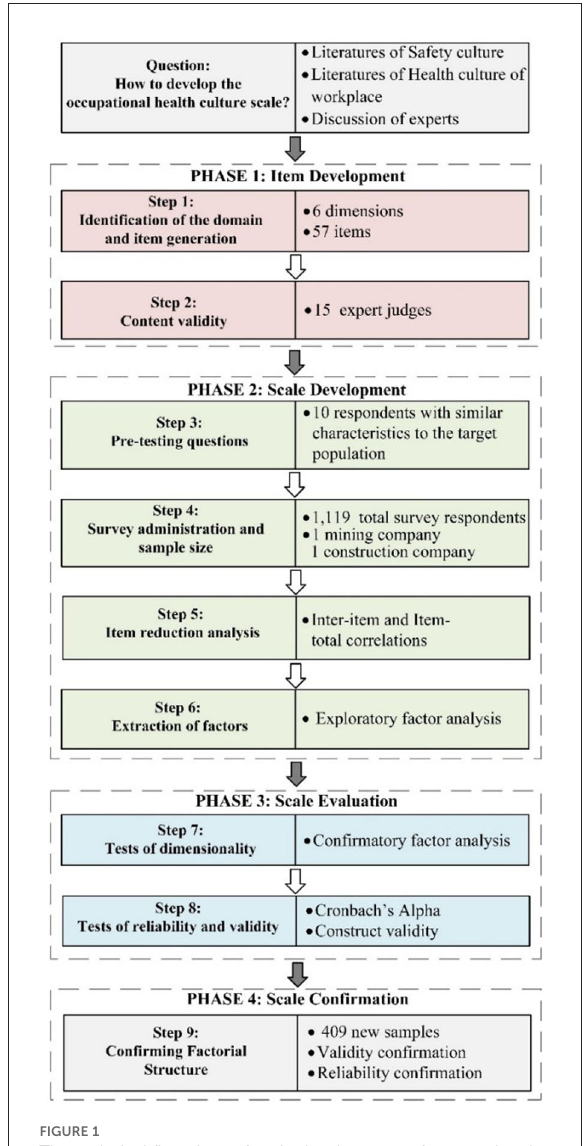
FIGURE1 The technical flowchart of scale development of occupational health culture.